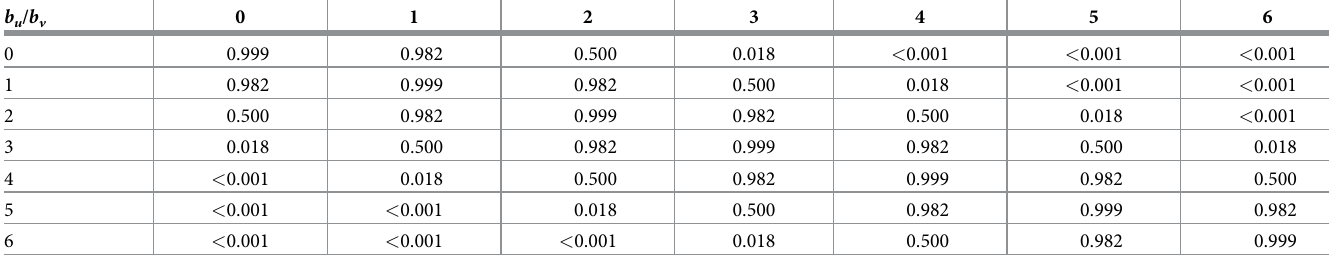
given prior b using u v